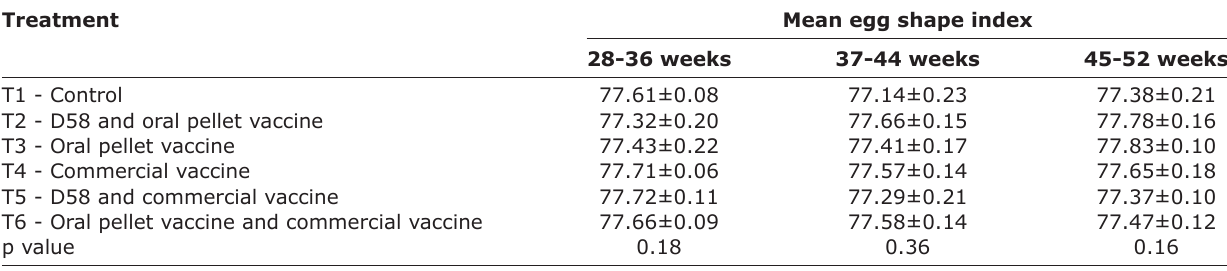
Table-3: Effect of different ND vaccine and vaccination regimen in desi chicken on egg shape index (mean±SE). Treatment